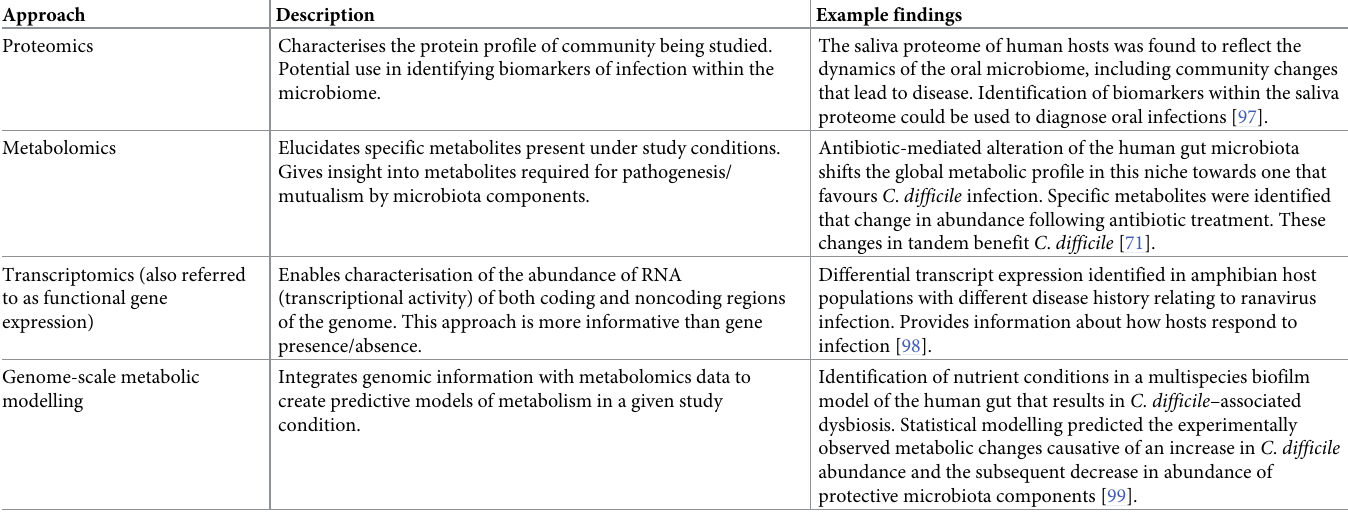
Table 2. Representative examples of omics approaches used to deduce the role of microbiota components in facilitating infection and worsening infection